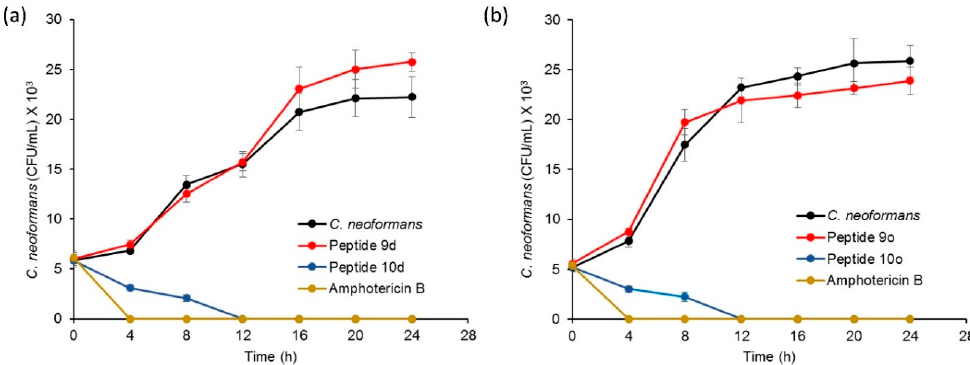
Figure 4. Time–kill kinetics profile for ( a ) peptide 10d , with amphotericin B as positive control, while C. neoformans cells and peptide 9d were negative controls; ( b ) peptide 10o , with amphotericin B as positive control while C. neoformans cells and peptide 9o were negative controls.